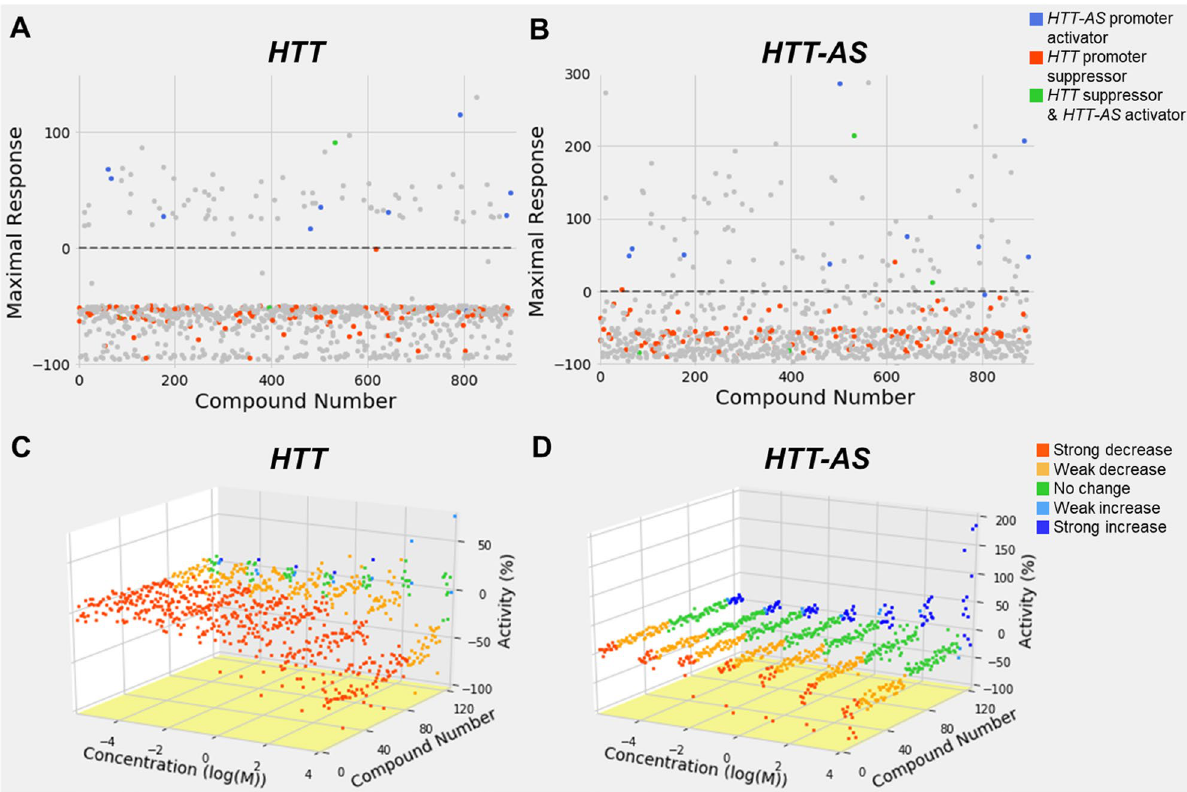
Figure 2. Replication of compound HTT and HTT-AS promoter activity. HTT or HTT-AS stable reporter cell lines were treated with 898 compounds identified in the HTS to replicate the initial findings. ( A , B ) Maximal response of luciferase activity at the highest dosage of compound treatment (57 μM) in ( A ) HTT- and ( B ) HTT-AS -promoter reporter cells. Hits were determined based on CRC values and are indicated in red ( HTT downregulators; HTT CRC = − 1/− 2/− 3), blue ( HTT-AS upregulators; HTT-AS CRC = 1/2/3), and green ( HTT downregulators AND HTT-AS upregulators). The remaining compounds with unfavorable or inactive CRCs are indicated in gray. One outlier (449%) from ( A ) and 3 outliers (843%, 458%, 403%) from ( B ) are not shown. ( C , D ) Waterfall plots of luciferase activity in ( C ) HTT and ( D ) HTT-AS reporter cells in response to treatment by 123 compounds chosen for further study. Red: strongly inactivating compounds (CRC = − 1.1/− 1.2/− 2.1/− 2.2). Orange: weakly inactivating compounds (CRC = − 1.3/− 1.4/− 2.3/− 2.4/− 3). Green: inactive compounds (CRC = 4/5). Cyan: weakly activating compounds (CRC = 1.3/1.4/2.3/2.4/3). Blue: strongly activating compounds (CRC =